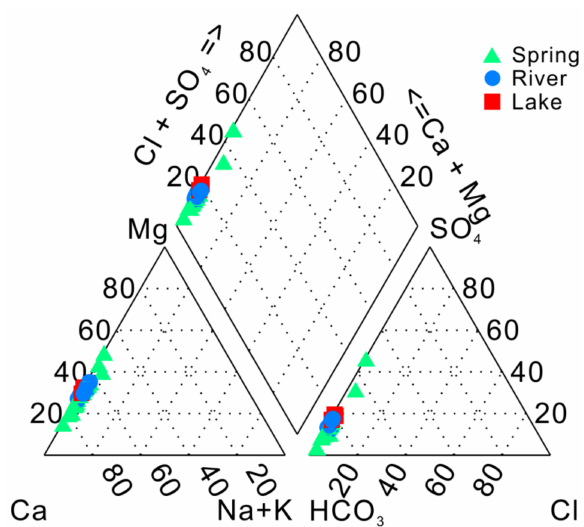
Figure 5. Piper diagram of the spring, river, and lake water samples; percentage concentrations in meq / L.